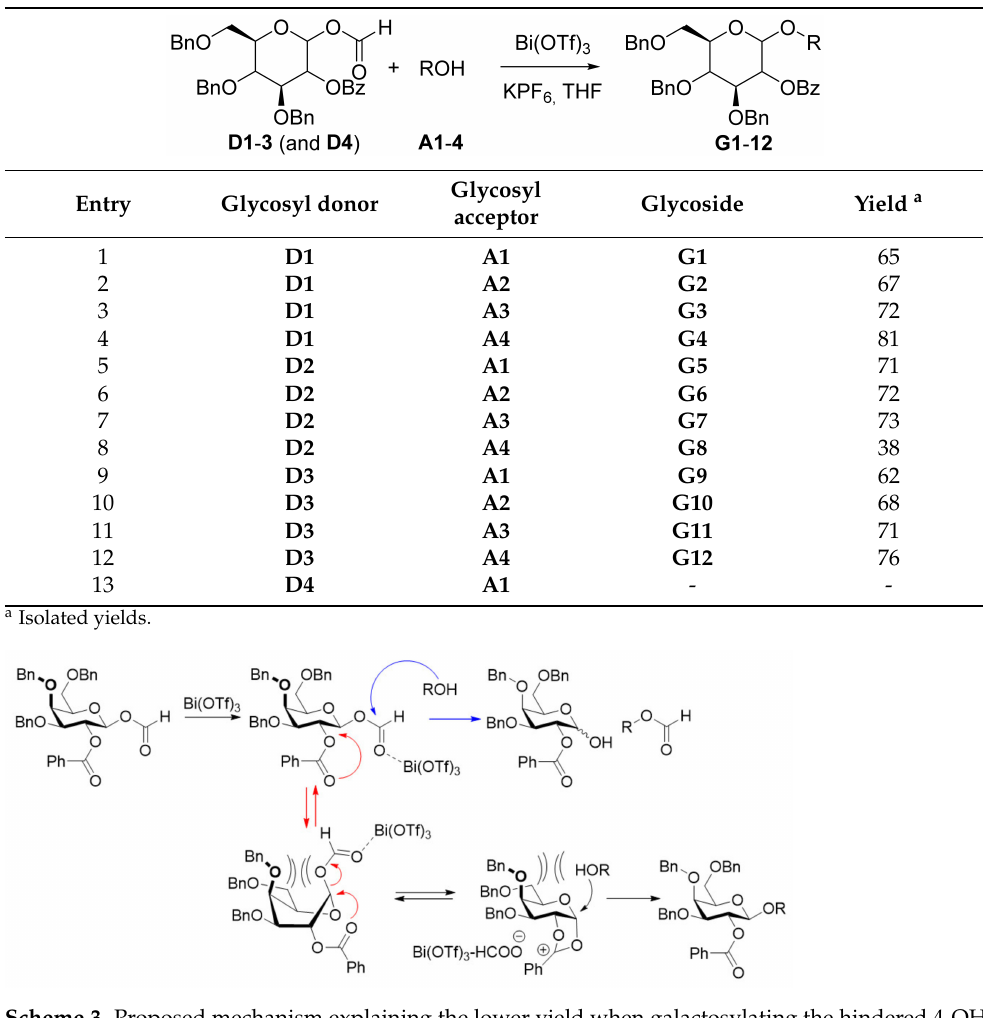
Table 1. General procedure for the glycosylations: Glycosyl donor (1 equiv.) was dissolved in THF (67 mM) and the glycosyl acceptor (1.15 equiv.) was added together with the catalyst (Bi(OTf) 3 25 mol%) and KPF 6 (1.15 equiv.) as an additive. The reaction was stirred at rt under an atmosphere of